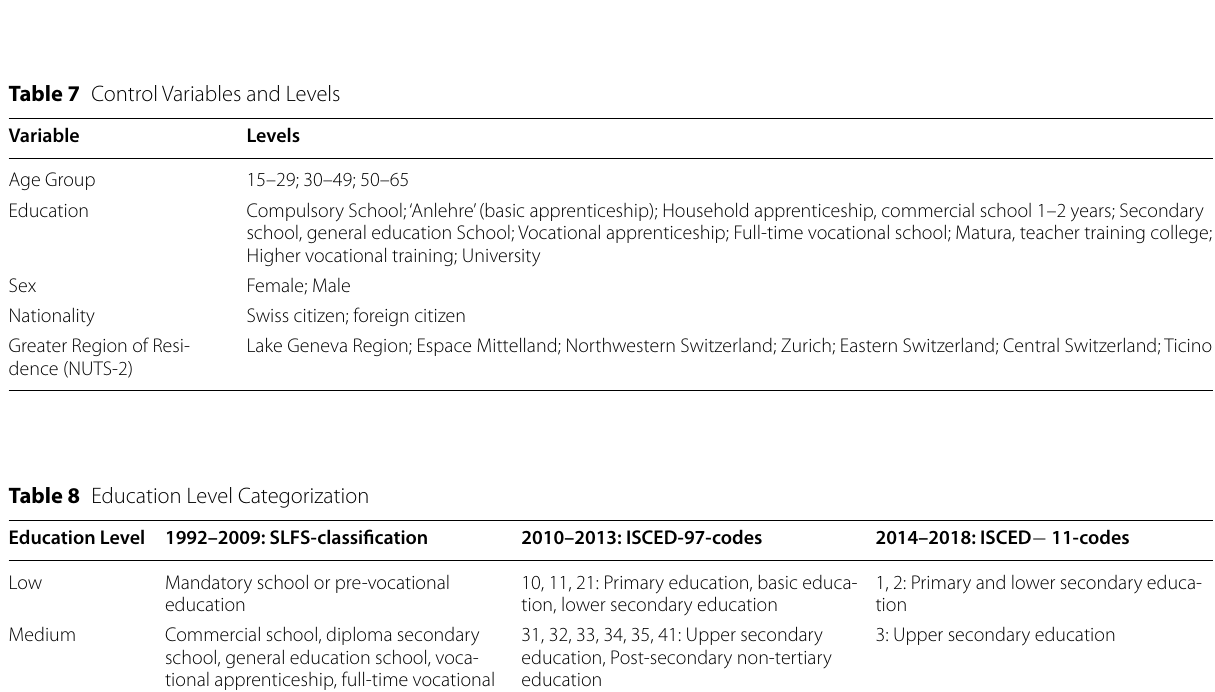
Examples taken from Mihaylov and Tijdens (2019).